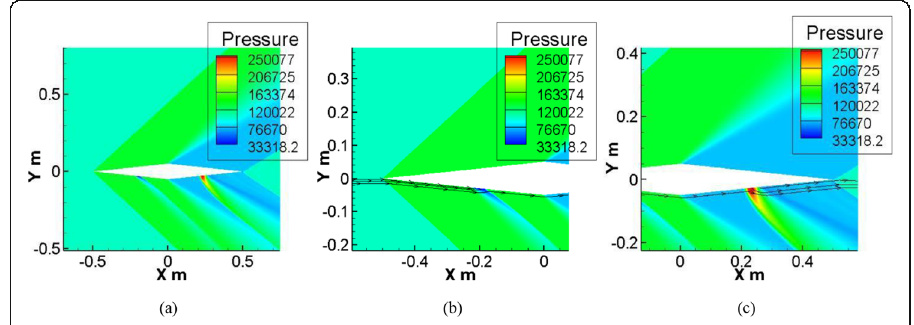
Fig. 11 Computed pressure contours with streamlines at the mass flow rate = 6.5 kg/s. a for the whole optimized diamond airfoil b for the suction slot c for the injection slot